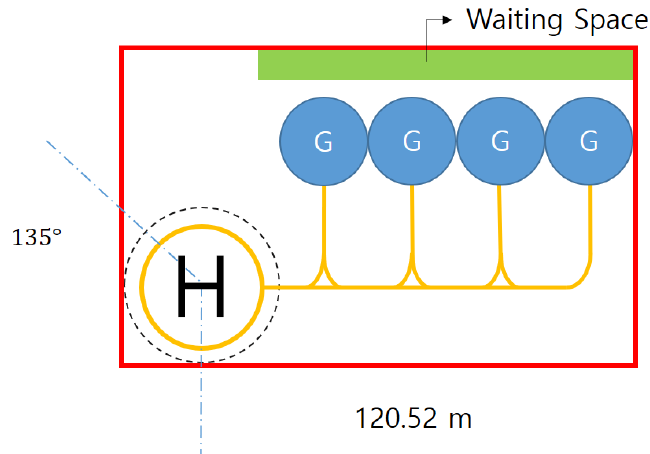
Figure 14. Example of pier topology that complies with the EASA’s new regulations.